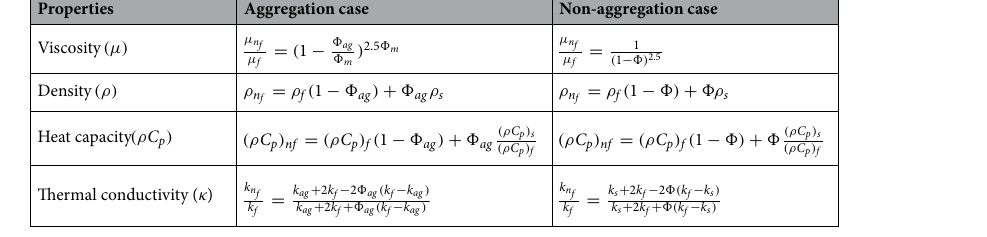
Table 2. Thermophysical properties model of nanofluid 40,41 .